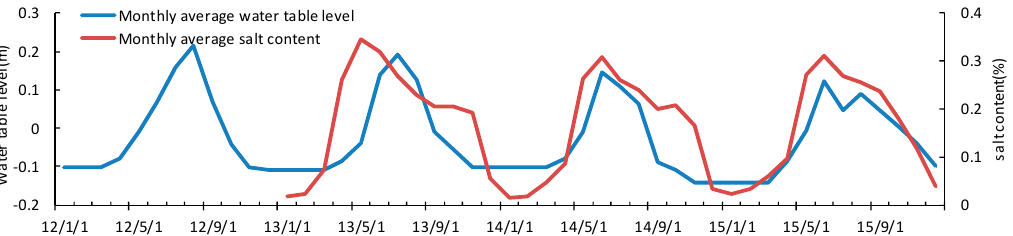
Figure 6. Water table level (WTL) and salinity change.